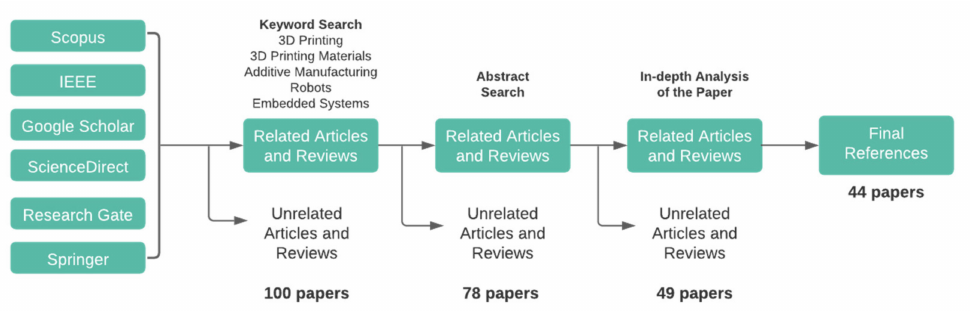
Figure 1. Flowchart showing the process used for the literature